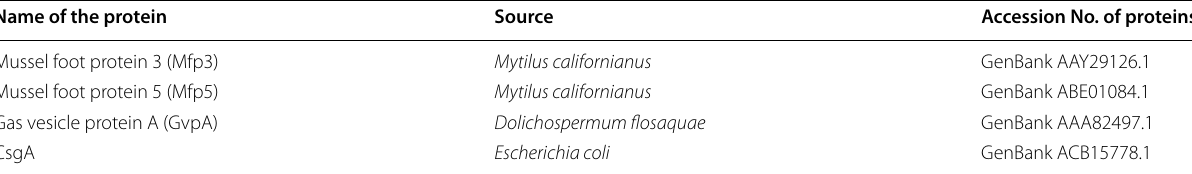
Table 1 List of proteins utilized in this study, their species’ origin, and accession numbers Name of the protein Source